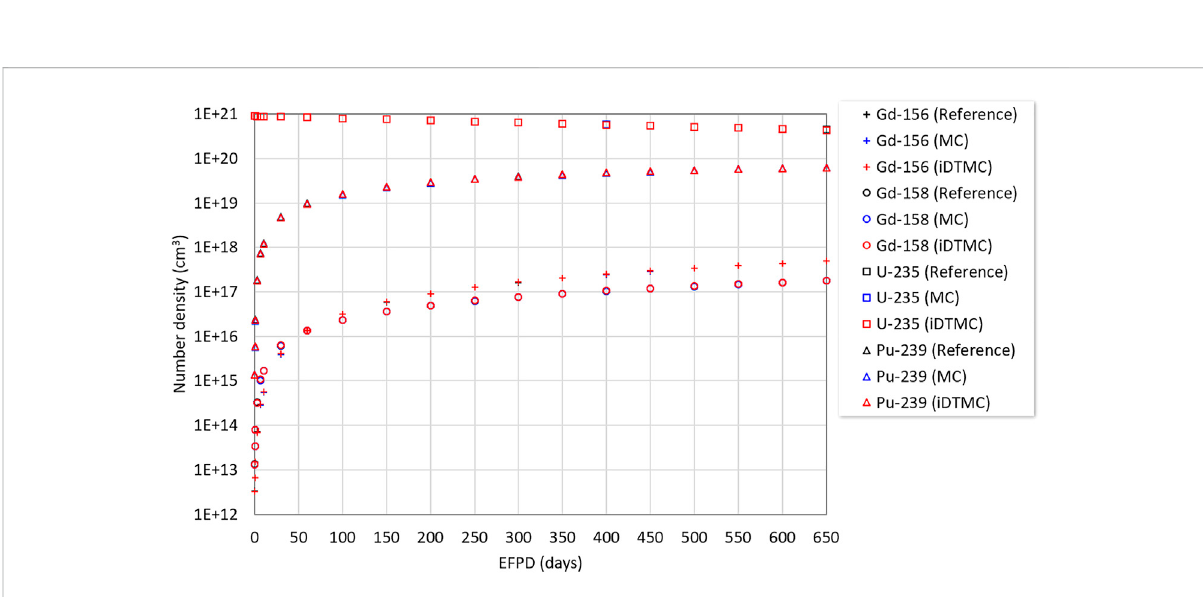
FIGURE 12 Number densities of the several isotopes in the